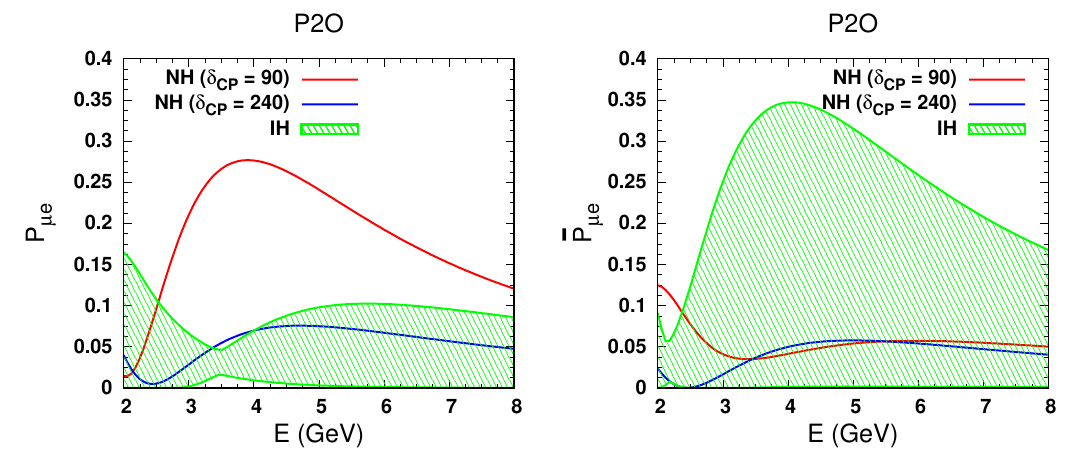
Figure 6 . Appearance channel probability for neutrinos (left panel) and antineutrinos (right panel) in the presence of NSI parameter | (cid:15) eτ | = 0 . 27 . The NH curves are generated for φ eτ = 290 ◦ , and δ CP = 90 ◦ and 240 ◦ . In IH these phases are